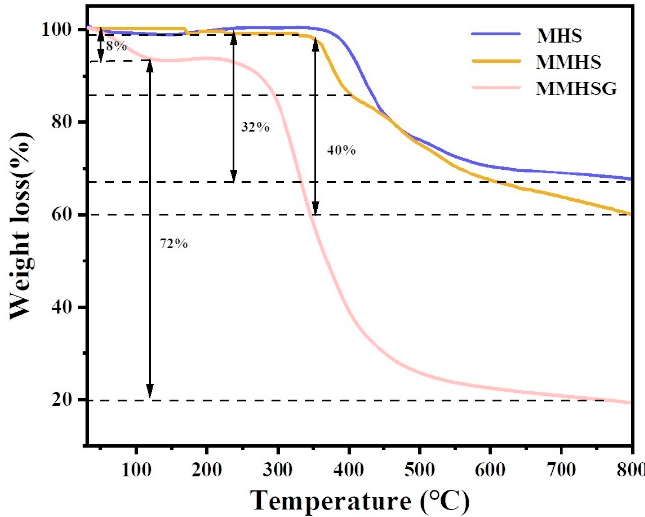
Figure 7. TGA curves of MHS, MMHS, and MMHSG.